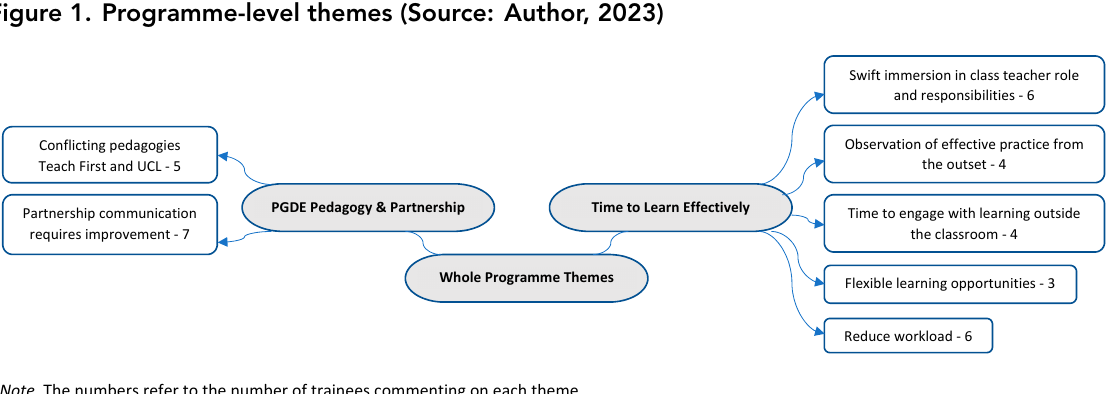
Conflicting pedagogies Teach First and UCL -